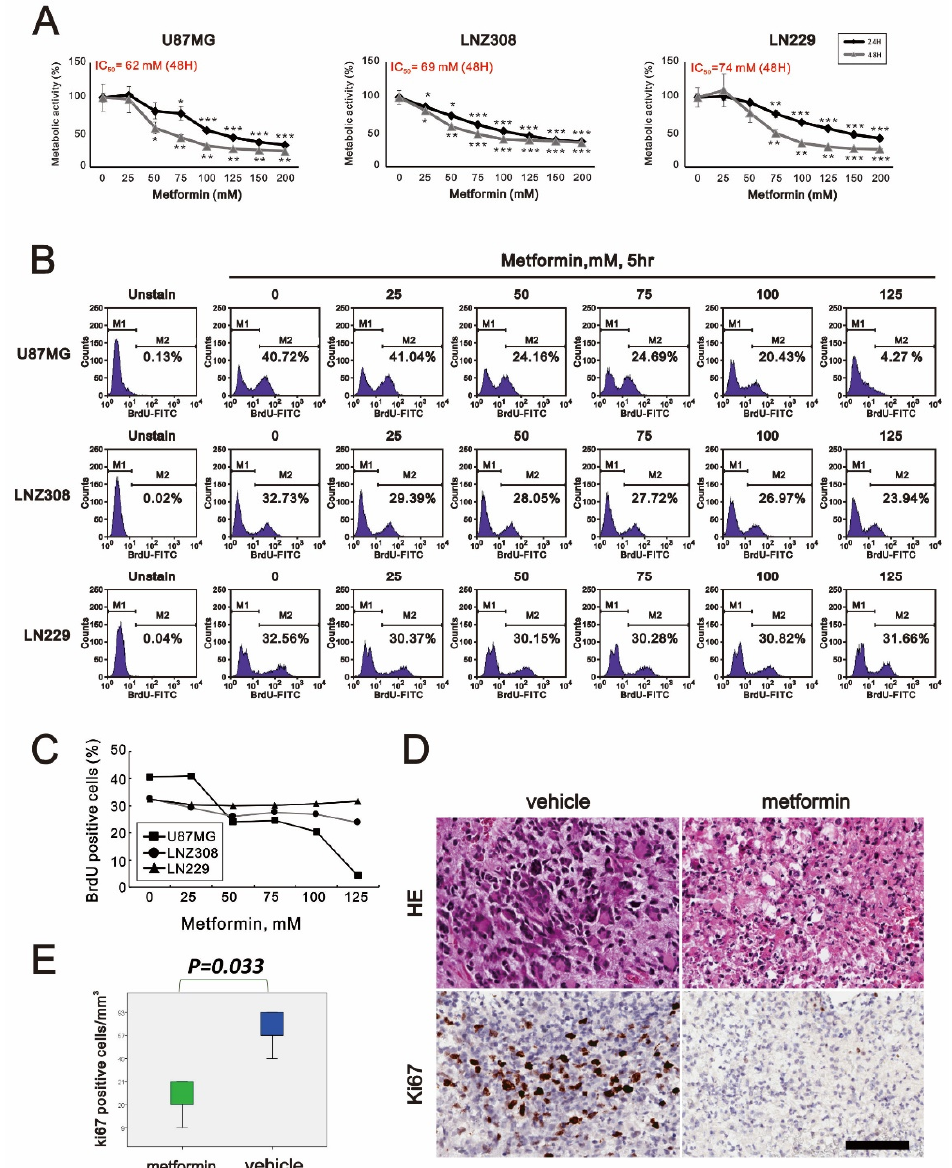
Figure 1. The effects of metformin on cell viability and proliferation in GBM. ( A ) U87MG, LNZ308, and LN229 cells were treated with the indicated metformin concentrations for 24 and 48 h. Metabolic activity was measured using MTS assays. * p < 0.05, ** p < 0.01, and *** p < 0.001. ( B ) U87MG, LNZ308, and LN229 cells were treated with the indicated metformin concentrations for 5 h. They were subjected to BrdU proliferation analysis and ( C ) their quantification. ( D , E ) Sliced GBM tissue was treated with vehicle (control) or 100 mM metformin for 3 days and statistically analyzed using Student’s t -test (significance was set at p < 0.05). Scale bar is 50 µm.